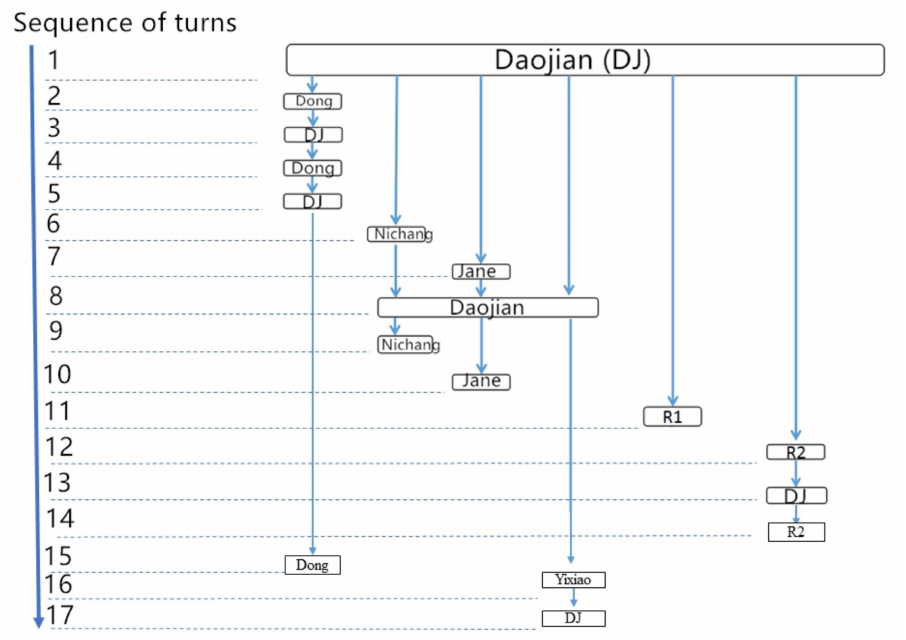
Figure 3. Trunk-branch